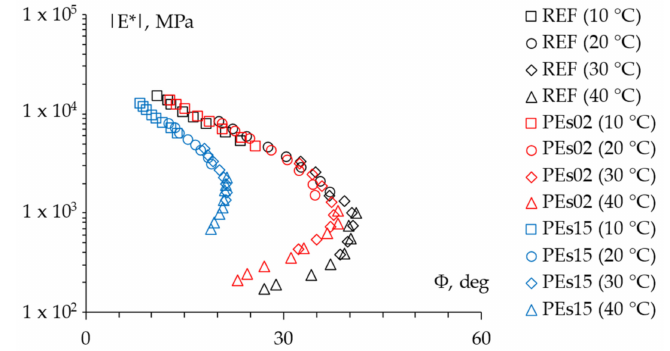
Figure 6. The 4PB experimental findings: Black